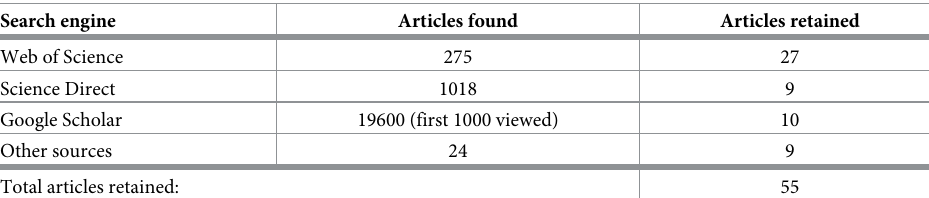
Table 1. Literature search